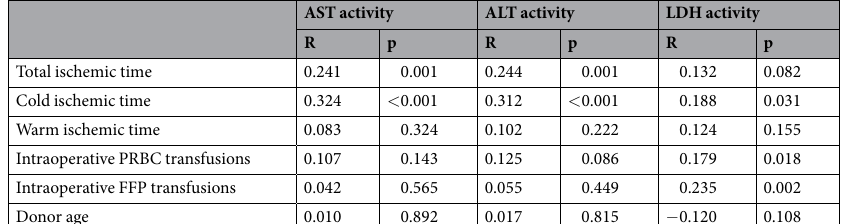
AST activity ALT activity